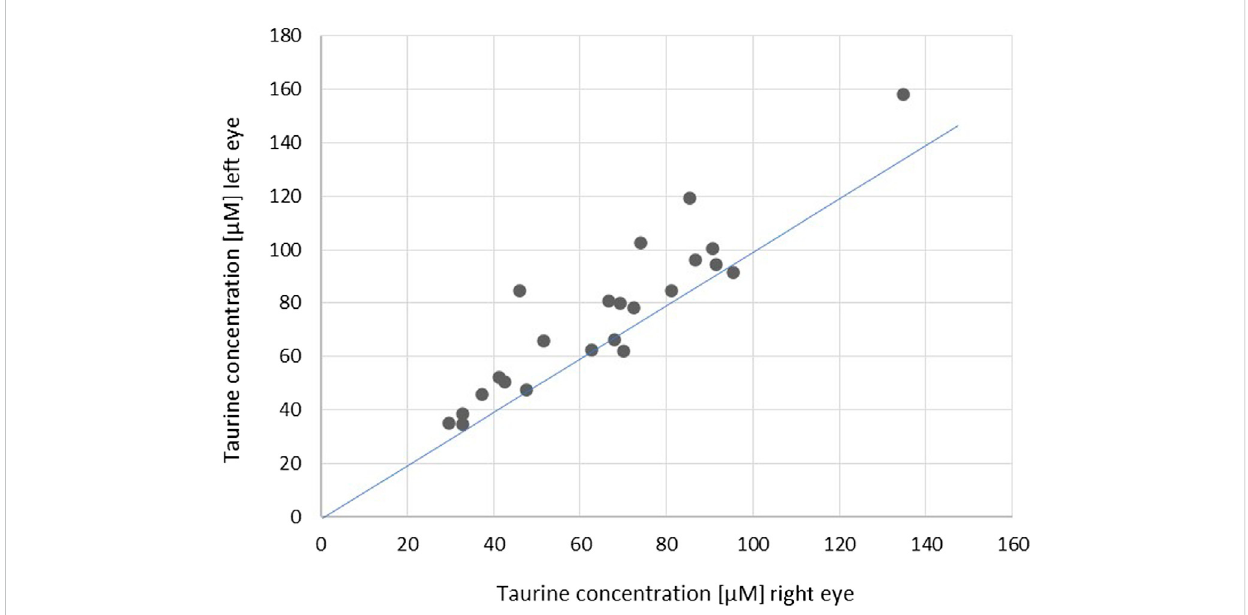
FIGURE 2 Scatterplot showing correlations of the concentration of taurine in fellow eyes (r = 0.89, p < 0.001; ICC = 0.861 [0.478 – 0.952]). The blue line indicates the theoretical perfect interocular agreement of